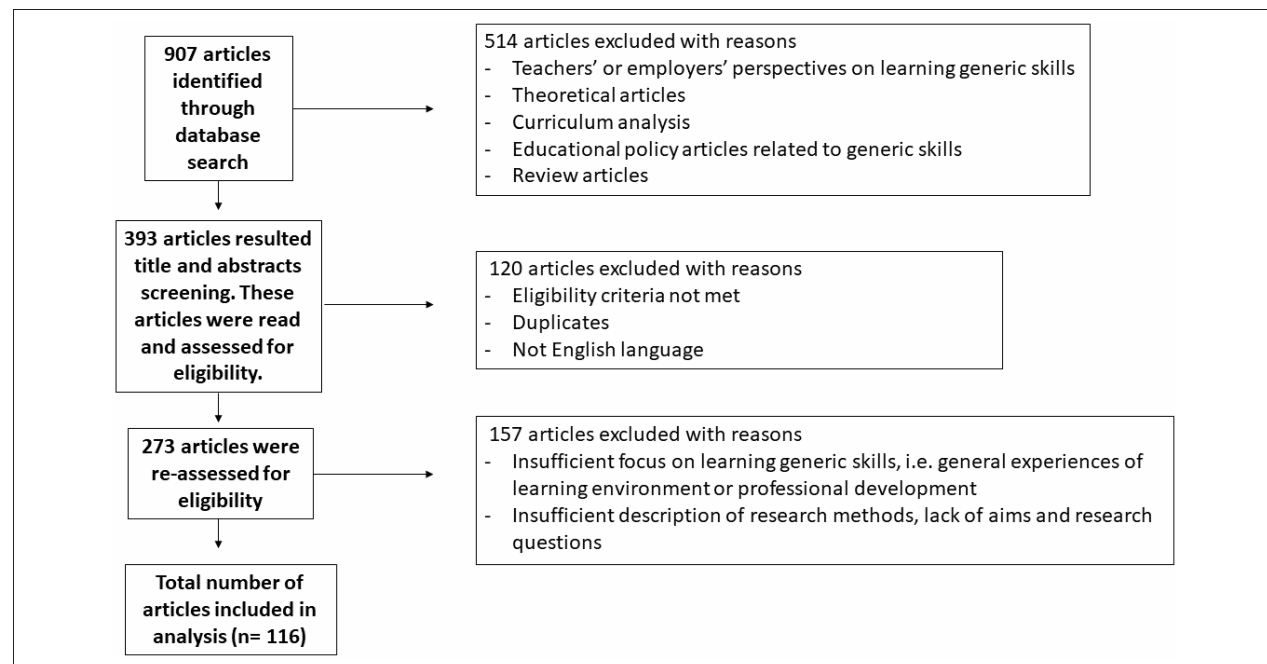
FIGURE 1 | Flow diagram of selection process.